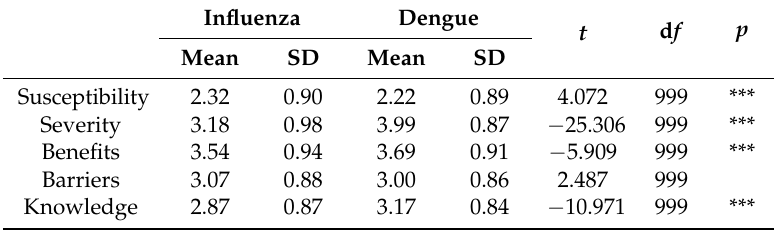
Table 2. Mean Comparisons of the predictors Between Influenza and